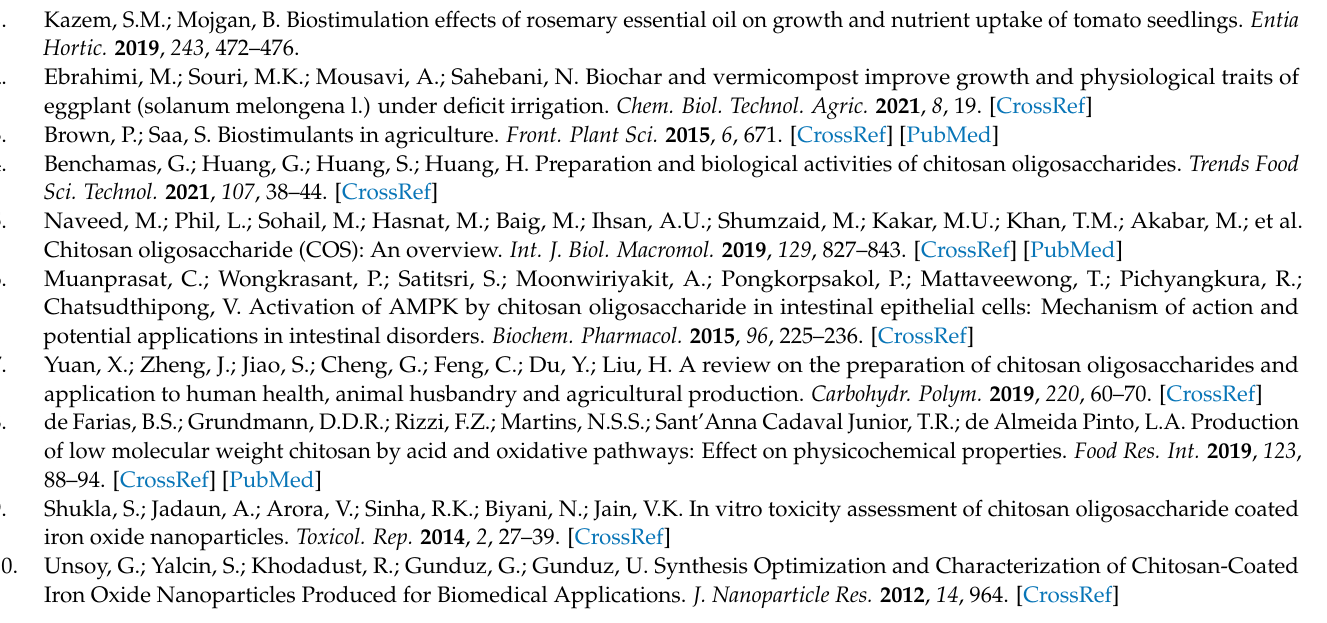
The list of deferent expression genes. Table S3: GO enrichment list of different expression genes. Table S4: KEGG pathway enrichment list of different expression genes. Table S5: Differentially expressed genes in plant hormone signal transduction pathway. Table S6: Deferentially expressed genes in alpha-Linolenic acid metabolism